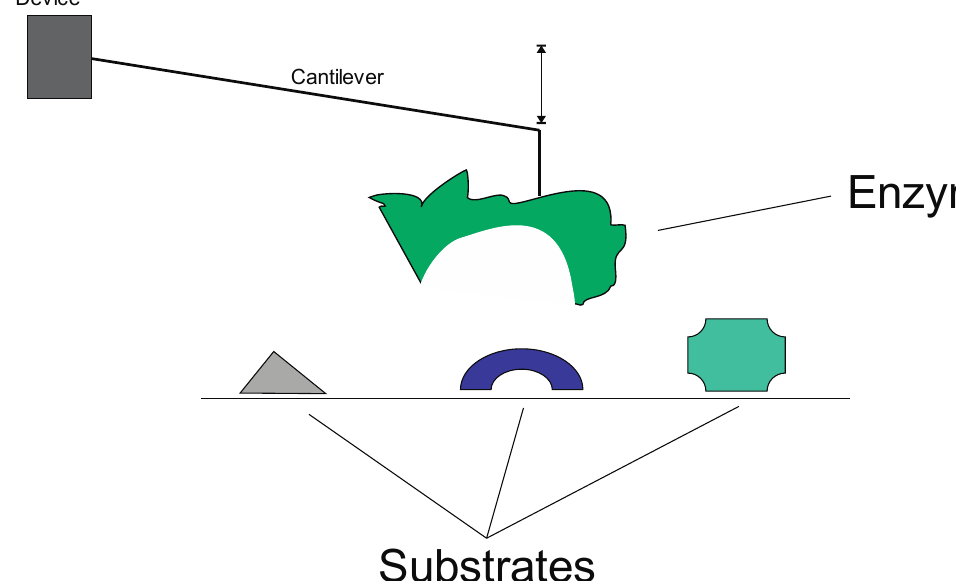
Figure 4. Single-molecule force spectroscopy is an AFM application. An enzyme, attached to a cantilever, is used as sensor, in strict analogy to AFM. As shown here, the enzyme is exposed to an array of substrates, depicted using shapes. The strength of the enzyme-substrate, derived from computer-assisted analysis of the recorded translocation of the cantilever, can then be used to develop biochemical assays (see the text for